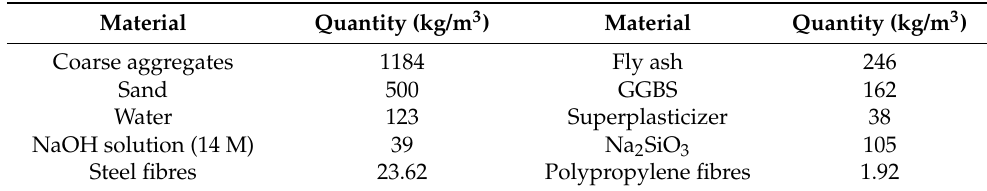
Table 2. Mix design of GFGC.